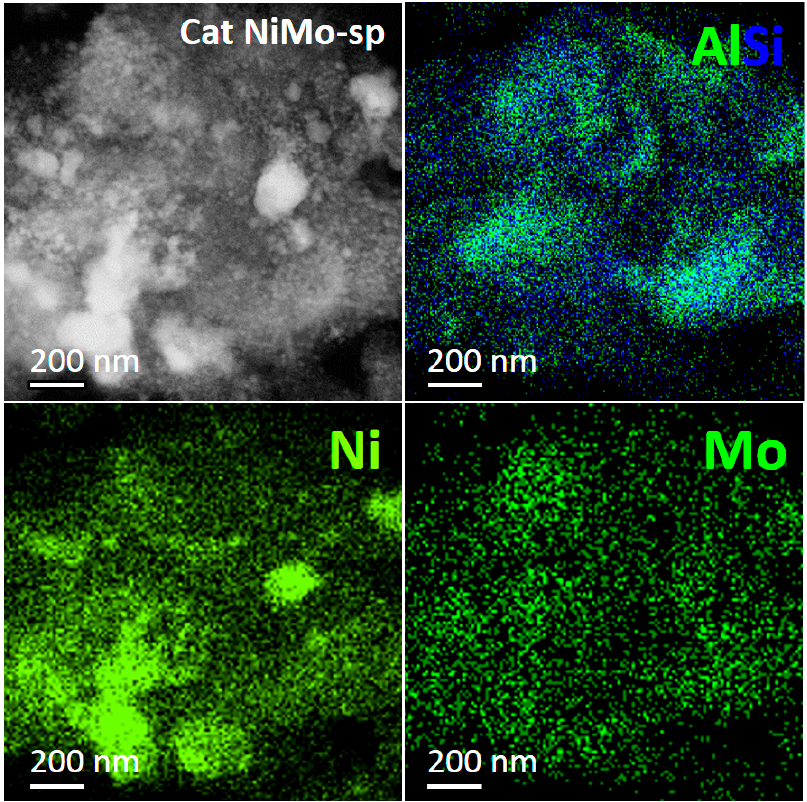
Figure 11. EDX mapping of spent NiMo / SiO 2 -Al 2 O 3 catalyst.